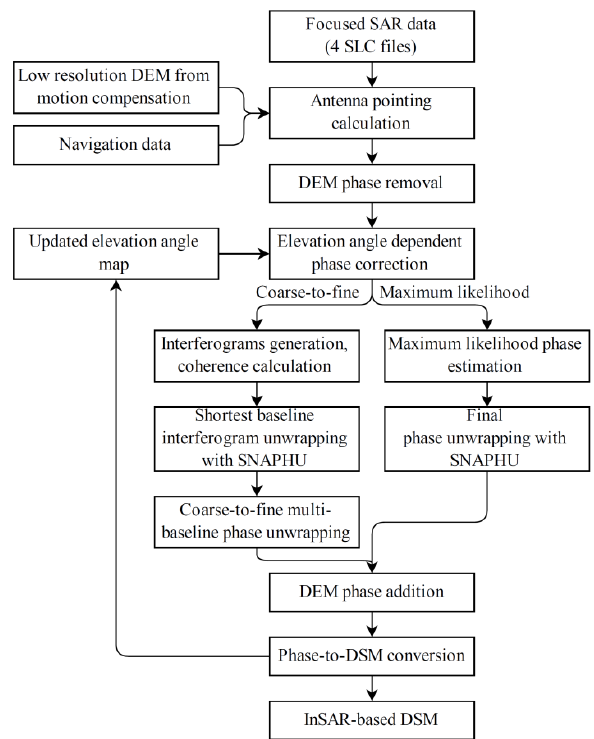
Figure 2. Block diagram of the InSAR processing chains for both C2F and ML methods.